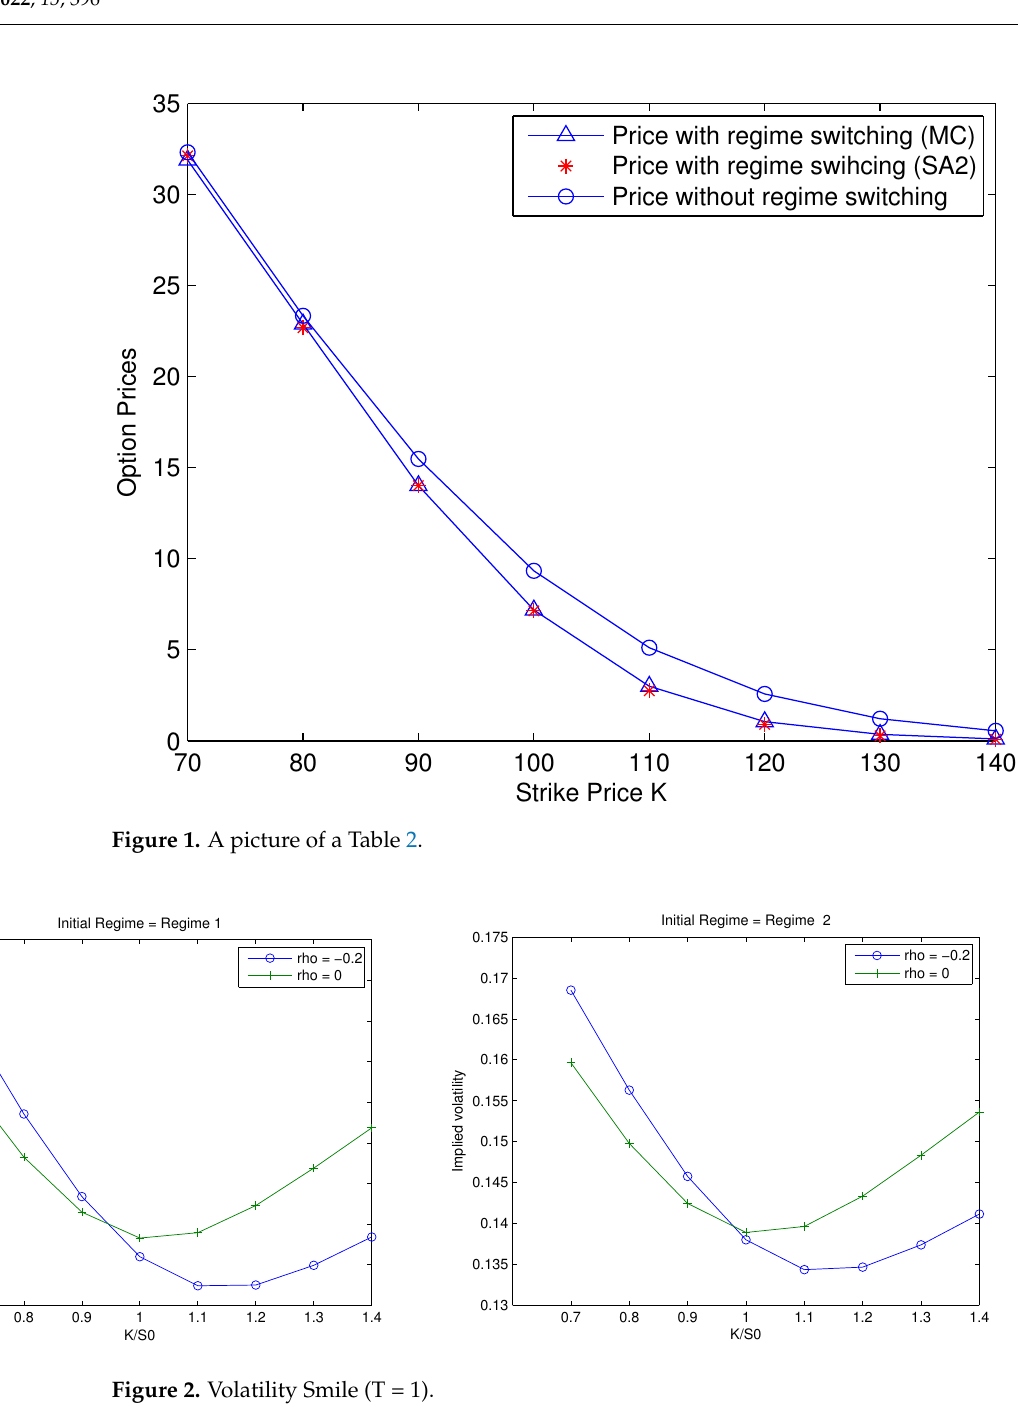
Figure 2. Volatility Smile (T =